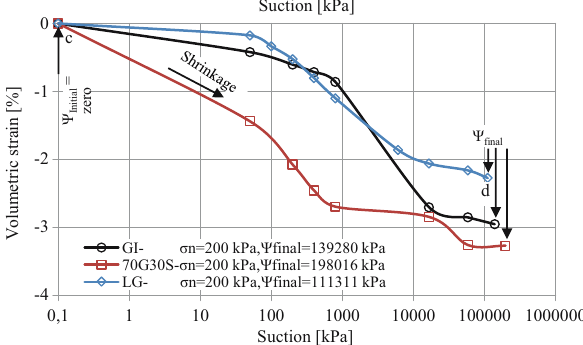
Figure 13: Variation of the degree of saturation with suction of the ( CN - SI ) drying test.